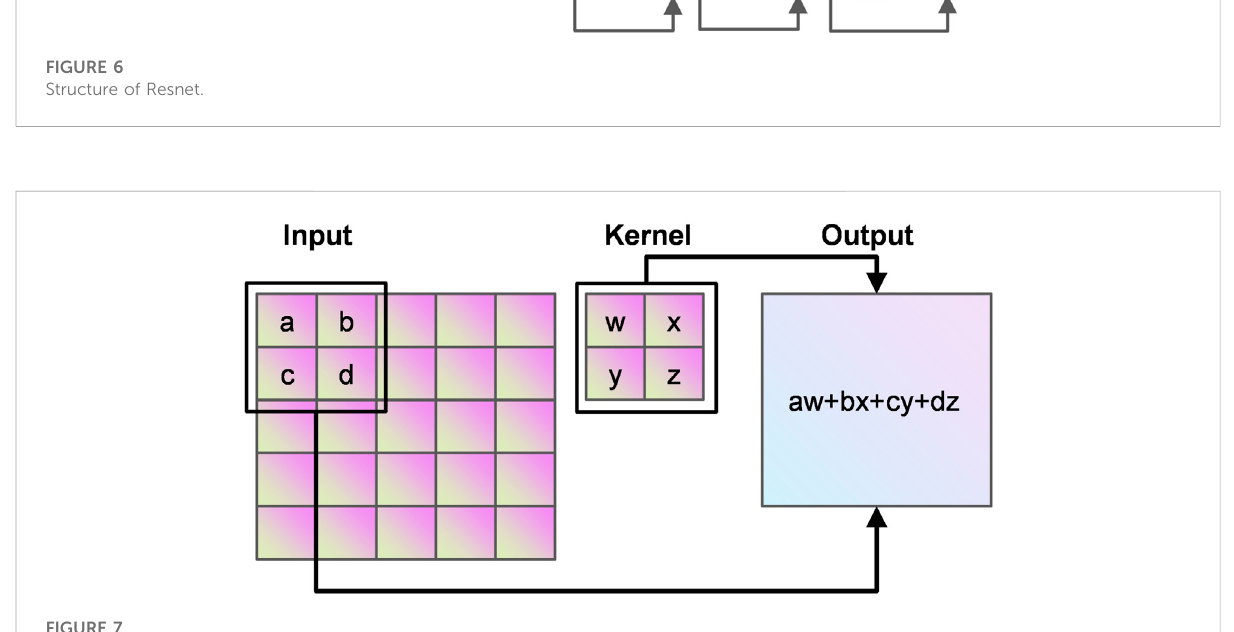
FIGURE 7 Principle of convolution.